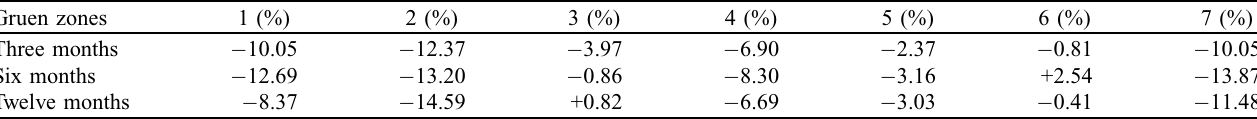
Table 3. Percentage of bone density changes at three, six, and twelve months postoperatively. Gruen zones